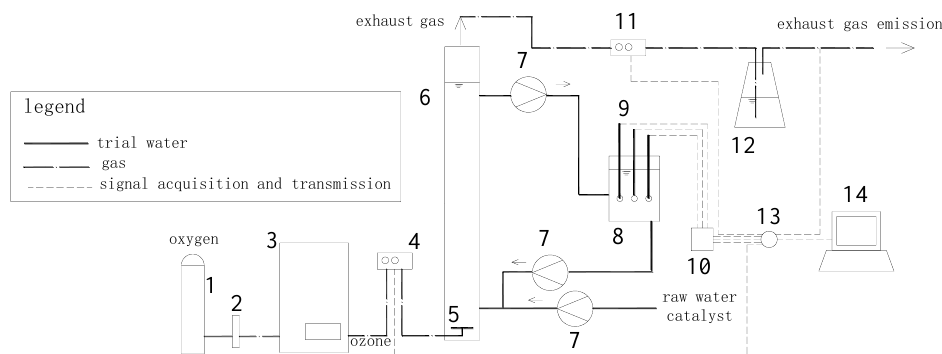
Figure 1. Ozonation experiment equipment online monitoring system diagram (1—oxygen cylinder; 2—gas flow meter; 3—ozone generator; 4—gas phase ozone concentration meter (in); 5—microporous aeration plate; 6—ozone contact oxidation tower; 7—pump; 8—constant flow meter; 9—pH, ORP, liquid phase ozone sensor; 10—pH, ORP, liquid phase ozone transmitter; 11—gas phase ozone concentration meter (out); 12—KI tail gas absorption bottle; 13—data acquisition module;